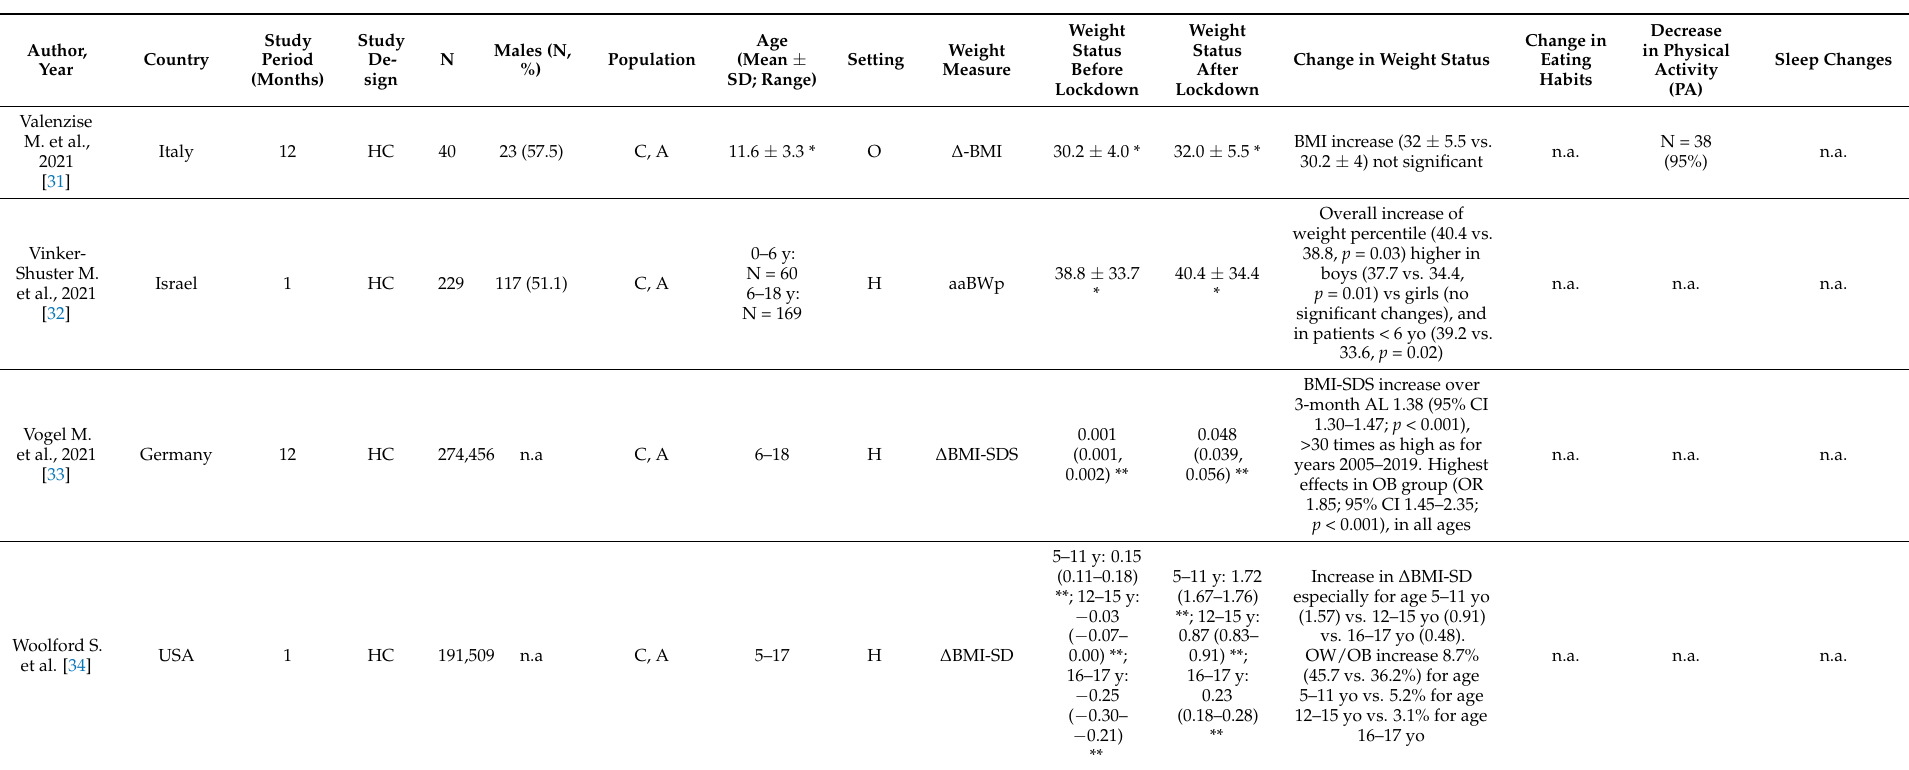
Legend to table: A = adolescents; aaBWp = age-adjusted body weight percentiles; AL = After Lockdown; BL = Before Lockdown; BMI = Body Mass Index (kg/m 2 ); BMI-SDS = standardized BMI; BW = Body Weight (kg); C = children d = days; m = months; y = years; CSS = cross sectional study; h = hours; H = hospital; HC = historical cohort; LS = longitudinal study; MFR = muscle to fat ratio; n.a. = not available; NW = normoweight; O = online; OB = obesity; OW = overweight; S = school; w = week; WC = waist circumference; W/H-r = waist/height ratio; yo = years-old; zBW = z-score; ∆ = difference from baseline. * = mean ± SDS; ** median and